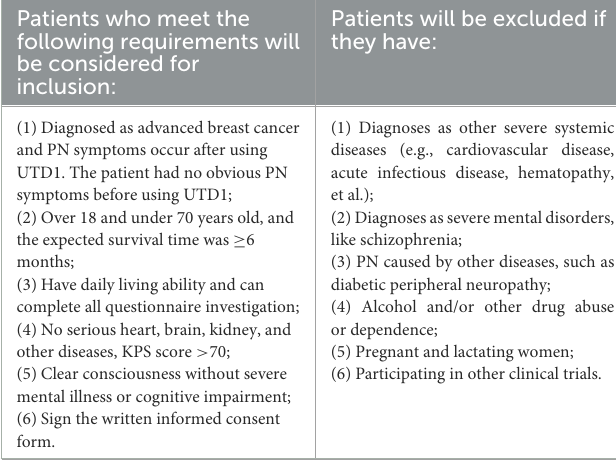
TABLE 2 Inclusion criteria and exclusion